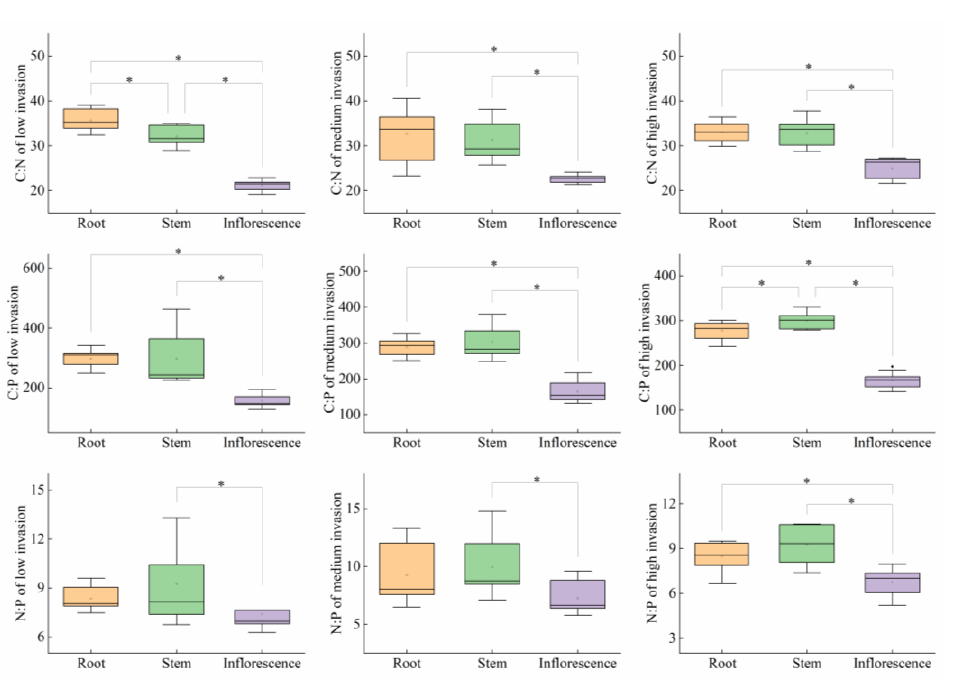
Figure 4. Differences of C:N, C:P, and N:P in structures of Pedicularis kansuensis among the different invasion levels. * indicates a significant difference ( p < 0.05). 4. Discussion 4.1. Pedicularis kansuensis Has Strong Phenotypic Plasticity Phenotypic plasticity is fundamental to biological adaptation and phenotypic evolu- tion [31], and is one of the primary pathways through which species adapt to heterogene- ous habitats [5]. Pedicularis kansuensis exhibits phenotypic plasticity in several